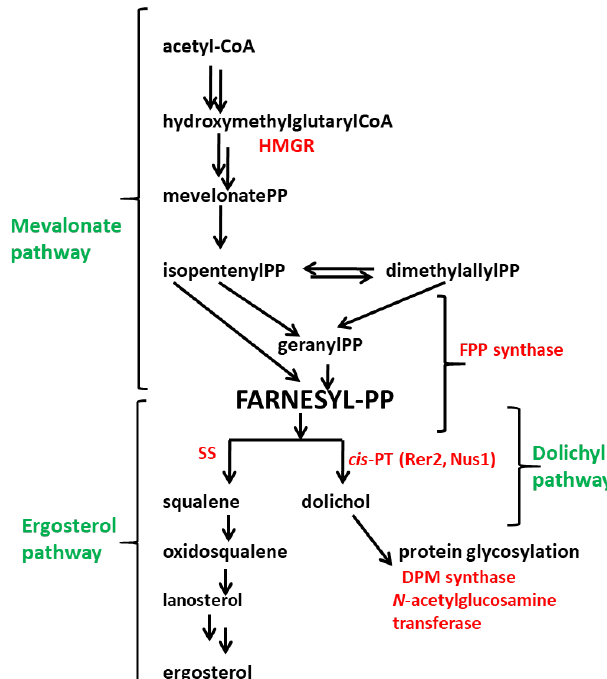
Figure 1. Metabolic pathways analyzed in this study. Abbreviations presented in the figure: HMGR—3 hydroxy-3-methylglutaryl–CoA reductase (regulatory enzyme of the mevalonate pathway); FPP synthase—farnesyl diphosphate synthase; SS—squalene synthase; cis -PT (Rer2)— cis -prenyltransferase; Nus1- cis -PT complex subunit; DPM synthase—dolichyl phosphate mannose synthase. The names of the pathways are marked in green, and the names of the enzymes analyzed in this study in